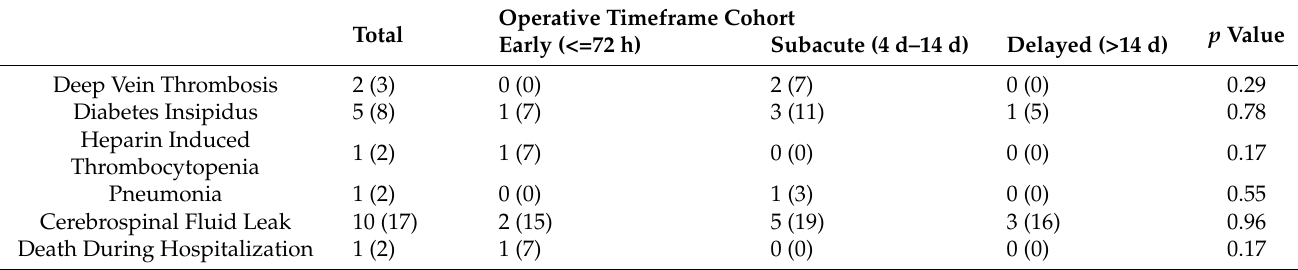
Figure 3. Correlation of Time to Surgery and Rapidity of Postoperative Recovery. Linear regression analysis and F-Test as performed to assess correlation in ( A )—CNs 3, 4, and 6, and ( B )—CN2.